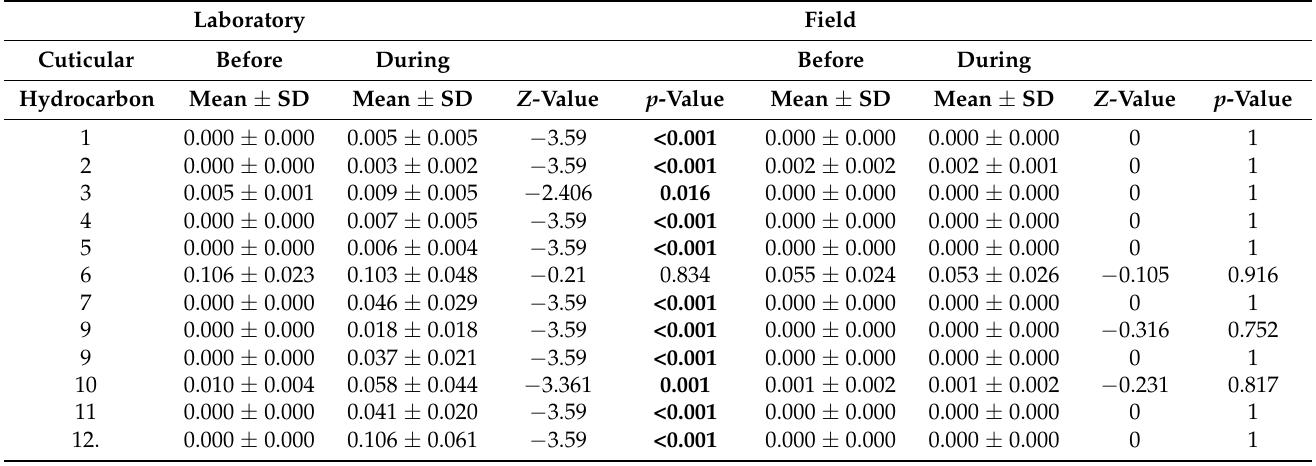
Table 3. Mean ± SD relative proportion of B. germanica cuticular hydrocarbon peak areas in L. humile profiles before and during the dietary treatment. Z scores and p values are from Mann-Whitney U-tests. Bold indicates p <